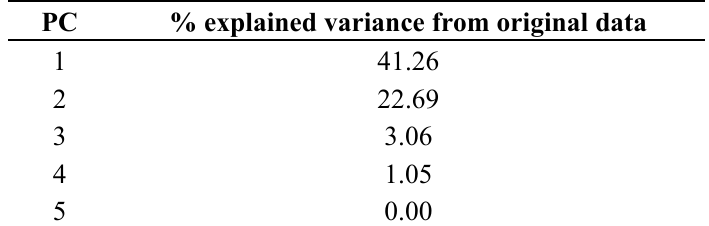
Table 2. Results of CPCA analyses of anti- Candida activities.